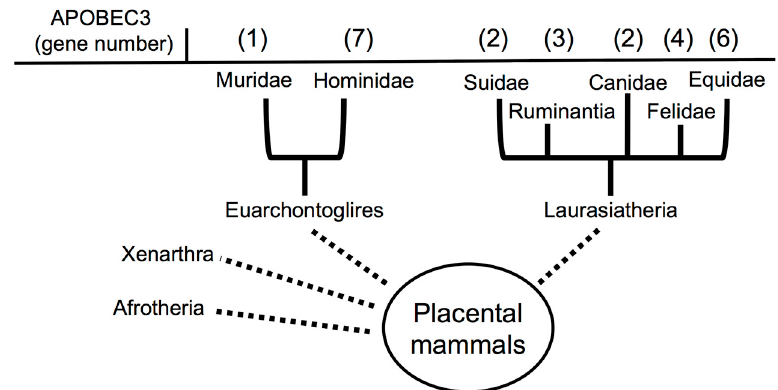
Figure 2. Copy number variation in mammalian APOBEC3s . Placental mammals are taxonomically split into four diverse groups (superorders), which include Afrotheria , Xenarthra , Euarchontoglires , and Larasiatheria . APOBEC3s have been described in the groups belonging to Euarchontoglires and Laurasiatheria . During mammalian speciation, A3s have evolved through a series of gene duplications, fusions, and losses. This has resulted in the copy number variability of mammalian A3s during speciation.